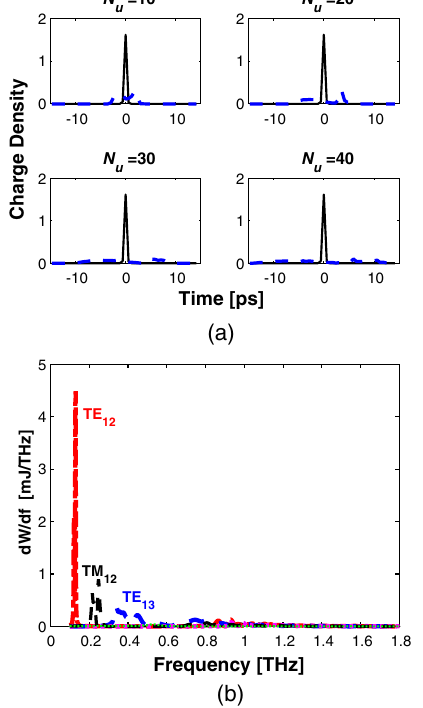
FIG. 3. Positive mass regime (under-resonance guiding field of 33 kG) for a single bunch with a charge of 1 nC: (a) initial and current charge density (the time is given relative to the bunch center; the particle motion to the tail of the distribution shifts the peak from the center of mass) and (b) radiation spectra of the dominant waveguide modes after N u ¼ 40 undulator